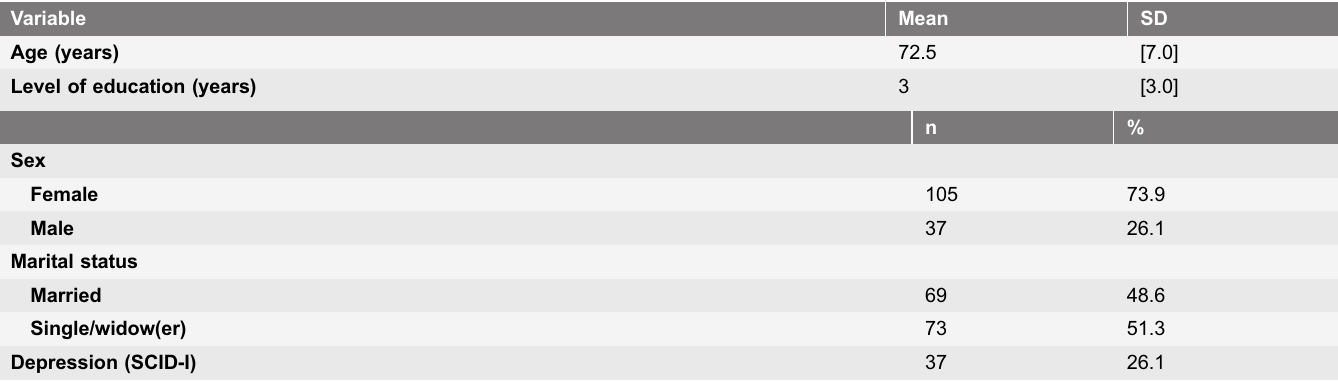
Table 1. Characteristics of the study participants (N 5 142).